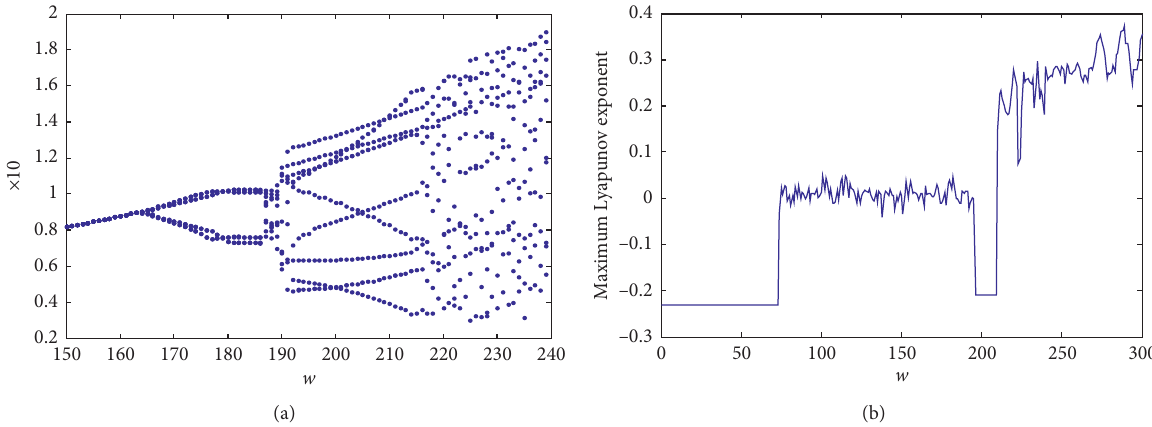
Figure 6: (a) Vibrational bifurcation diagram without perturbation. (b) Maximum Lyapunov exponent curve without perturbation.